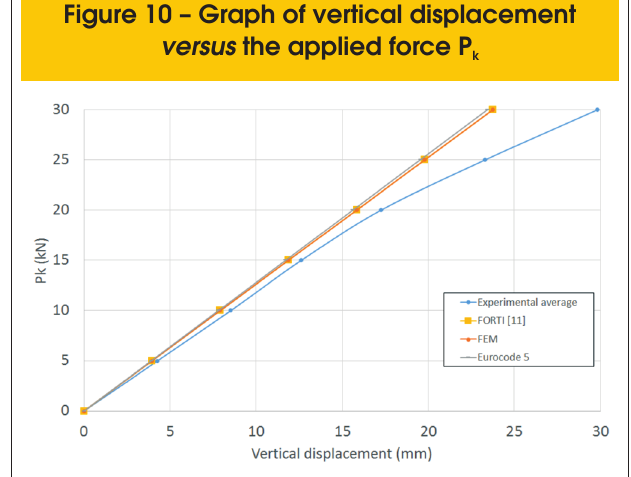
Figure 10 – Graph of vertical displacement versus the applied force P